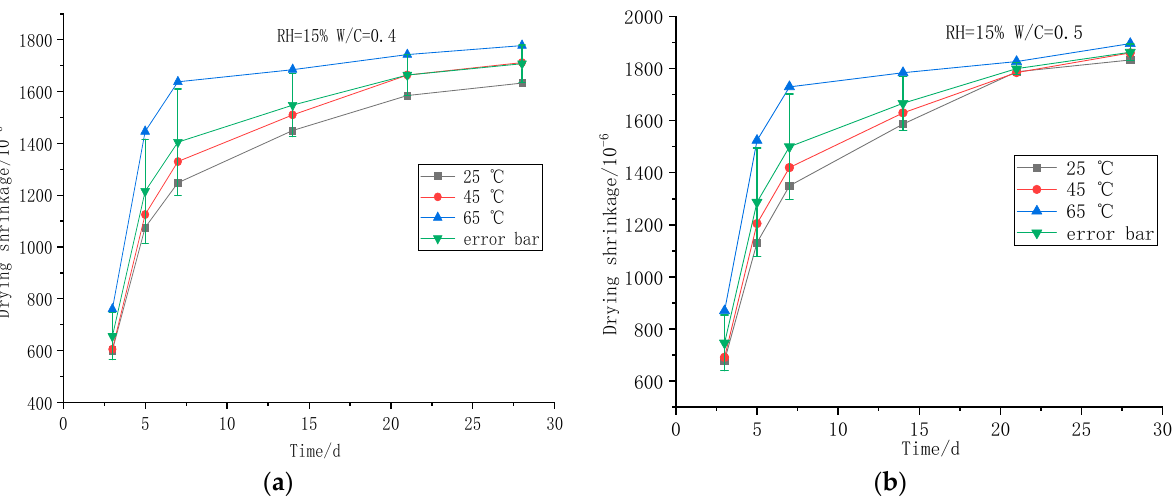
Figure 7. Drying shrinkage of foamed concrete under different curing temperatures (RH = 15%): ( a ) 0.4 water–cement ratio dry shrinkage of foamed concrete; ( b ) 0.5 water–cement ratio dry shrinkage of foamed concrete.